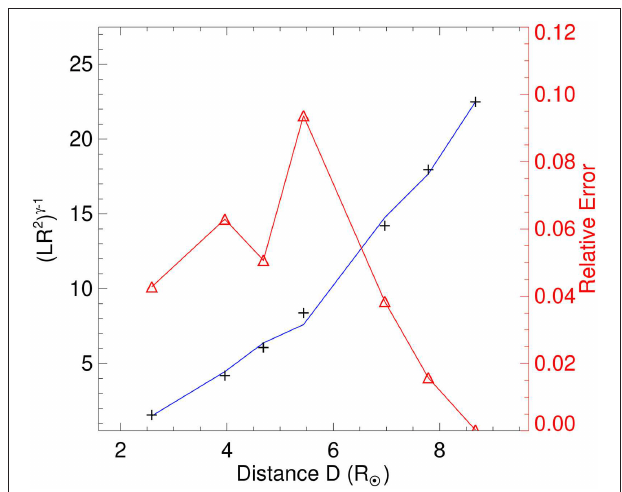
FIGURE 5 | The variations in ( LR 2 ) γ − 1 from the measurements (black), the modeled result for this parameter (blue), and the relative error (red) in the model results are